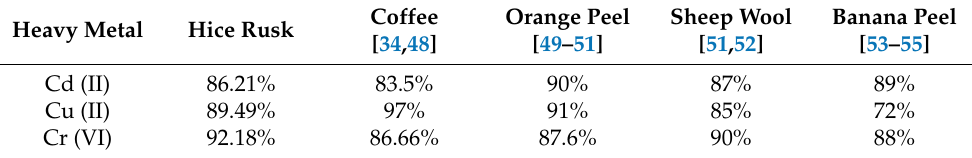
Table 8. Comparison of efficiencies of rice husk with other lignocellulosic materials.